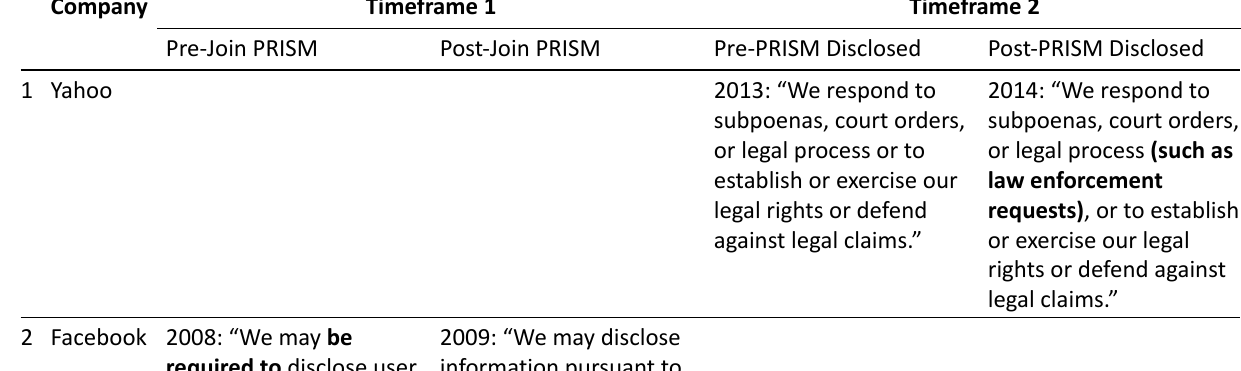
Table A.2. Privacy policy changes related to data sharing and tracking.